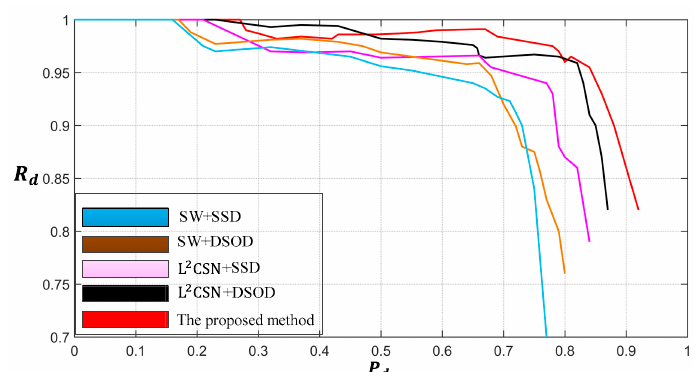
Figure 10. The P d − R d curves of the di ff erent detection methods. Figure 10. The 𝑃 (cid:3031) − 𝑅 (cid:3031) curves of the different detection methods.